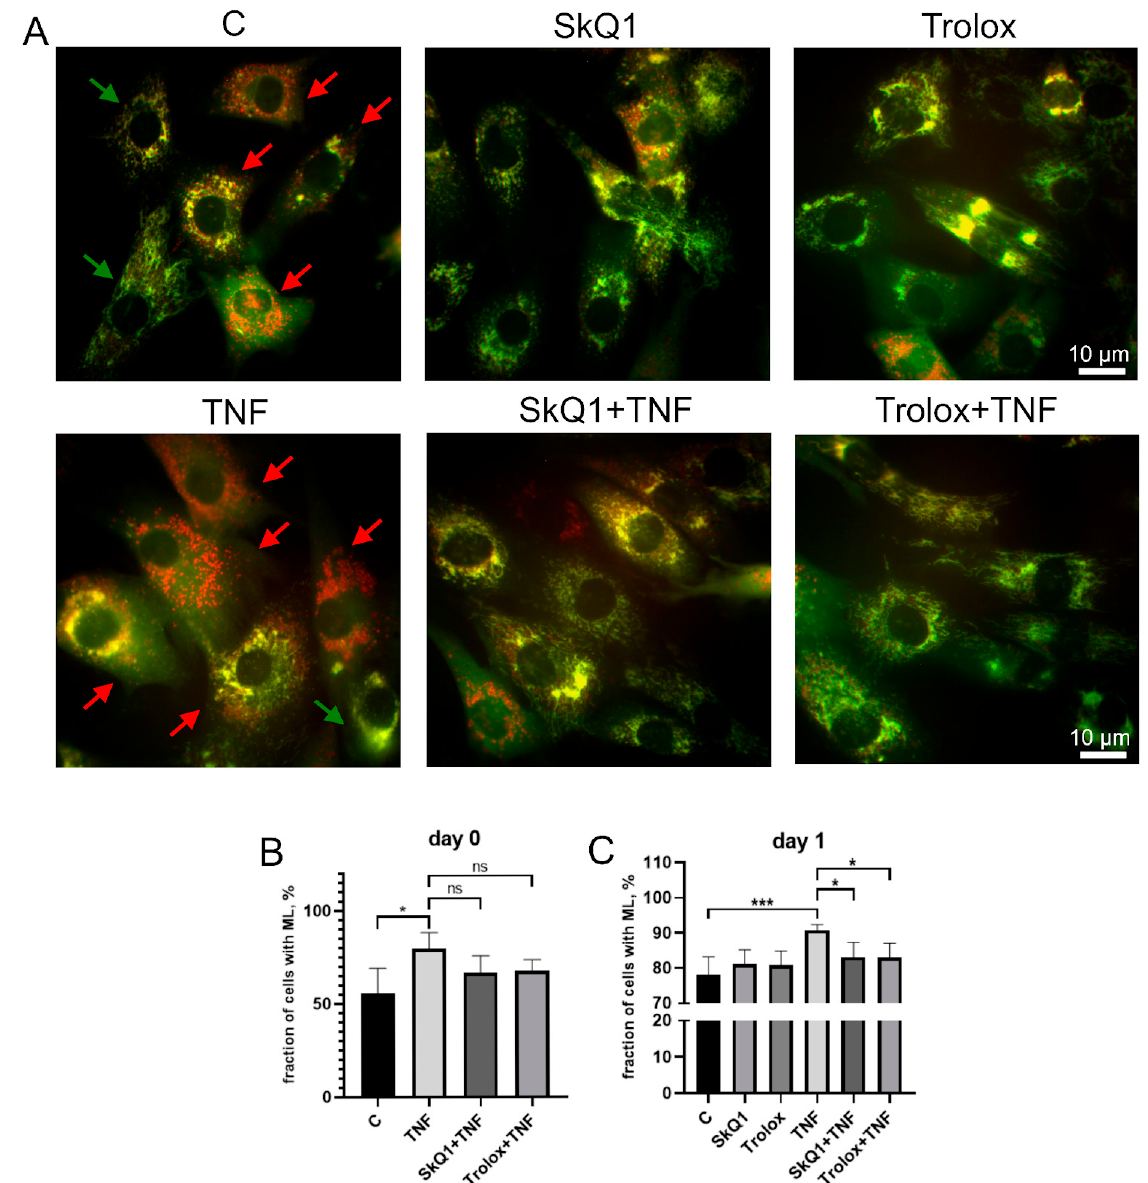
Figure 5. Antioxidants inhibit TNF-induced excessive mitophagy in differentiating myoblasts. Cells were treated with 50 ng/mL TNF 24 h before the induction of differentiation. SkQ1 (40 nM) and Trolox (100 µ M) antioxidants were added 48 h before TNF and then again into the differentiation medium. For mitophagy analysis, cells were transduced with the mito-QC construct. Mitolysosomes (ML) are stained in red. Scale bar: 10 µ m. The fraction of cells containing ML was measured on the day 0 and day 1 in the control and TNF-treated myoblasts. ( A ) Representative images of cells transduced with the mito-QC construct and treated with antioxidants and TNF, 24 h after differentiation induction. Red arrows indicate cells with ML and green arrows indicate cells without ML. Scale bar: 10 μ m. ( В , C ) Morphometric analysis of the